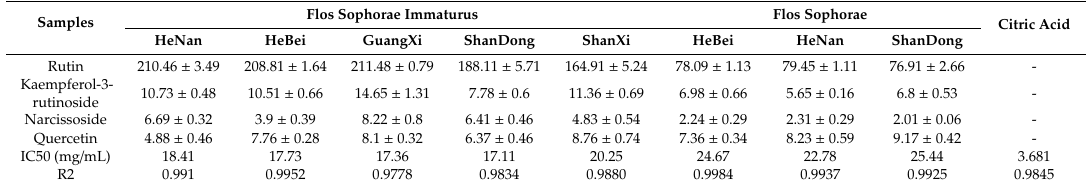
Table 6. Contents of four compounds in di ff erent samples (mg / g), and the IC 50 values of samples and Citric acid ( n = 3).